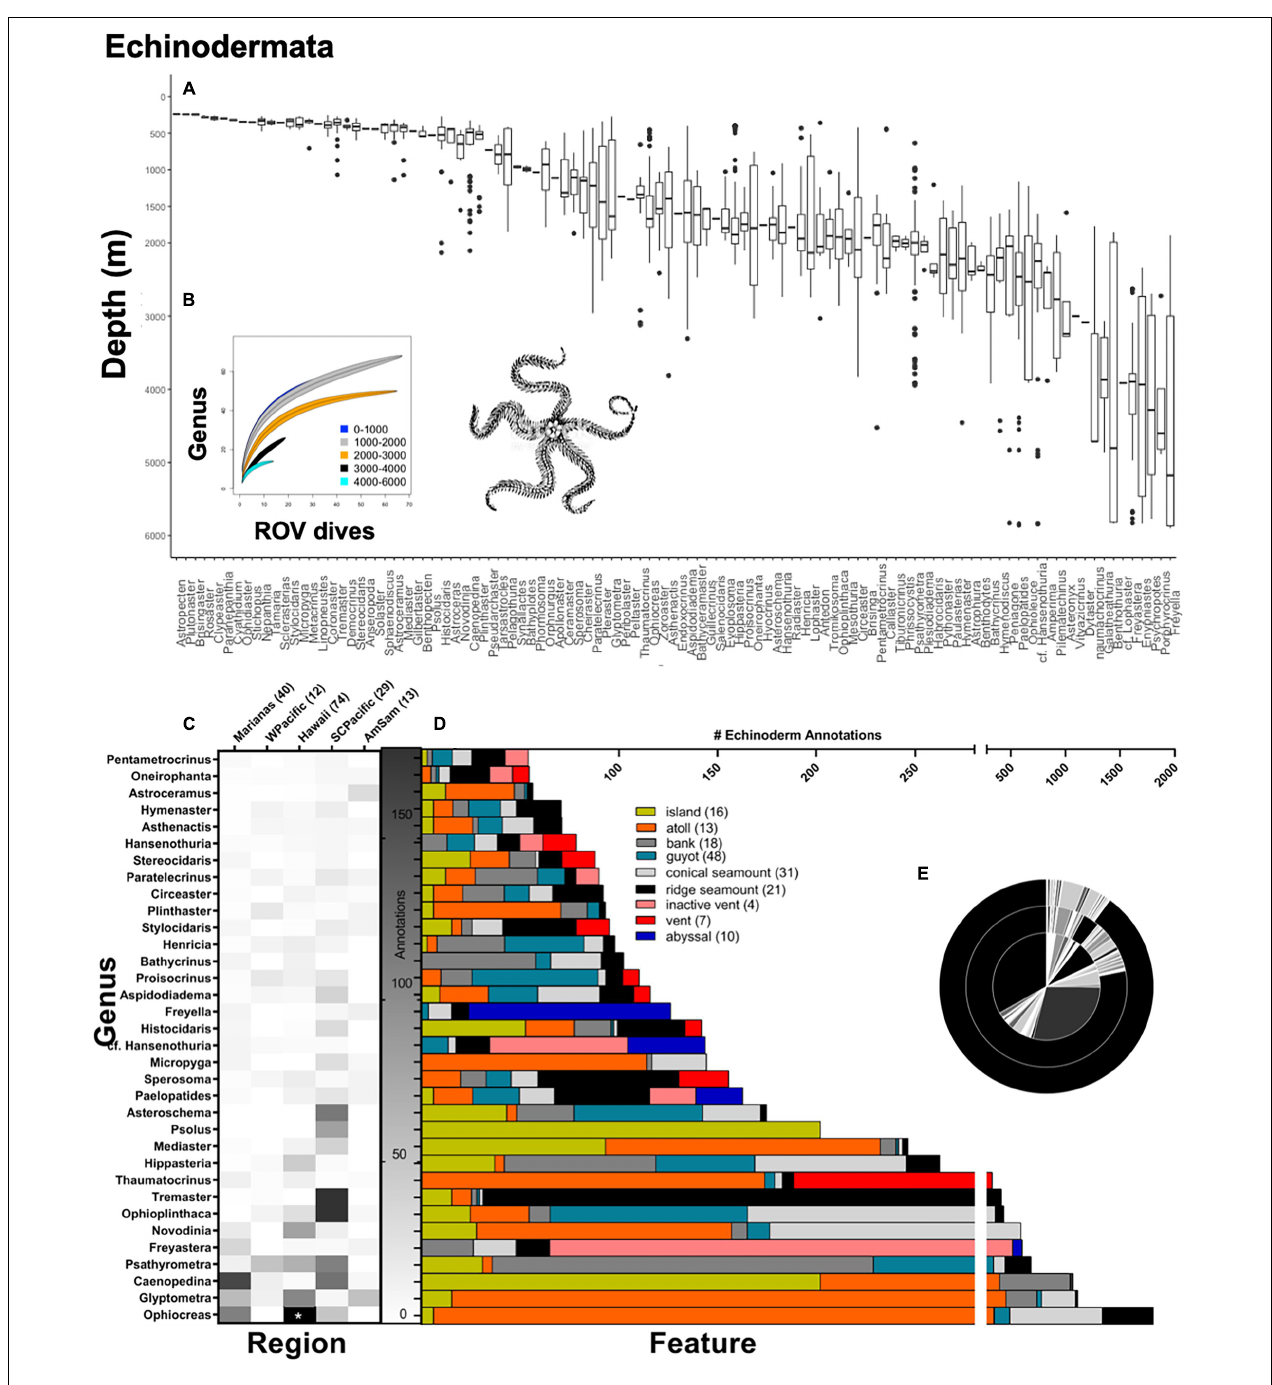
FIGURE 6 | Top panel: Echinoderm annotations at the genus-level demarcated by depth (m). (A) A total of 29,934 echinoderm annotations were used to make box-and-whisker plots, organized from shallow to deep along the x -axis. A total of 106 echinoderm genera were observed over CAPSTONE. Rarefaction curves (B) are shown for all of Echinodermata (106 genera), color coded by depth 0–1,000 m (blue) 1,000–2,000 m (gray), 2,000–3,000 m (orange), 3,000–4,000 m (black), and 4,000–6,000 m (cyan). Lines are drawn with a 95% confidence envelope. Bottom panel: Echinoderm annotations representing at the genus-level demarcated by (C) geographic region and (D) geologic feature; the number of dives for both are in associated parentheses. A total of 34 echinoderm taxa are shown, representing every genus where 50 observations or more were made during CAPSTONE. Starred boxes on heatmap represent abundances outside the range represented, specifically, 417.32 Ophiocreas spp. were observed (corrected for effort) in the Hawaiian Islands Region. Axis breaks by feature do not omit any data; breaks instead allocate annotation effort on different scales. (E) Nested pie chart shows overall taxonomic diversity at the family level (inner circle), genus level (middle circle), and species level (outer circle), for all echinoderms annotated. Unidentified annotations are represented by the largest black bar originating at 12:00, progressing counter-clockwise.